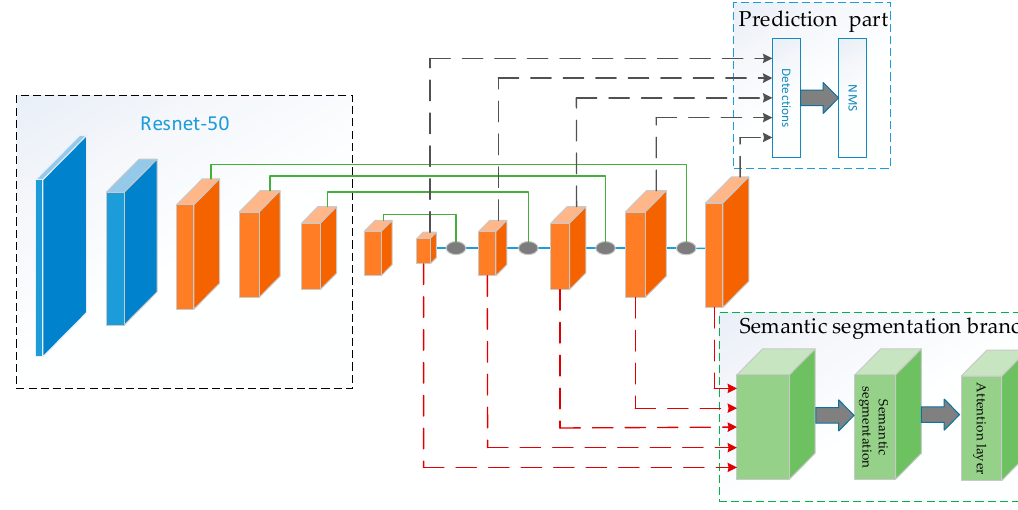
Figure 1. The flow chart of the proposed algorithm.